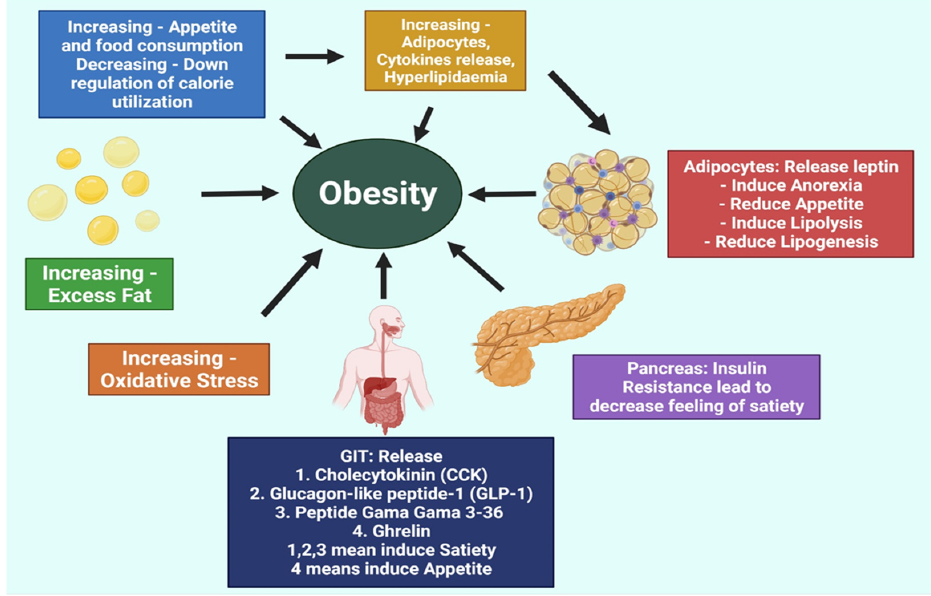
Figure 1. The fundamental model of obesity’s etiology. GIT, gastrointestinal tract.